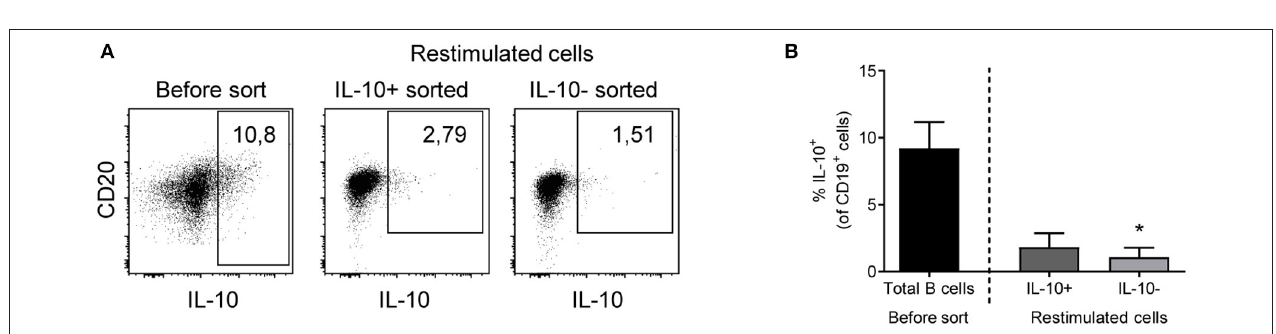
FIGURE 6 | IL-10 expression by in vitro- stimulated human B cells is a transient trait. IL-10 + (dark gray) and IL-10 − (light gray) B cells were sorted on day 3 and re-cultured in B cell medium for 3 days. After PIB restimulation, IL-10 expression was assessed using intracellular staining ( B ; n = 3). Representative dot plots are shown (A) . Black bar depicts IL-10 + B cells before sort. Friedman test was performed. * p <